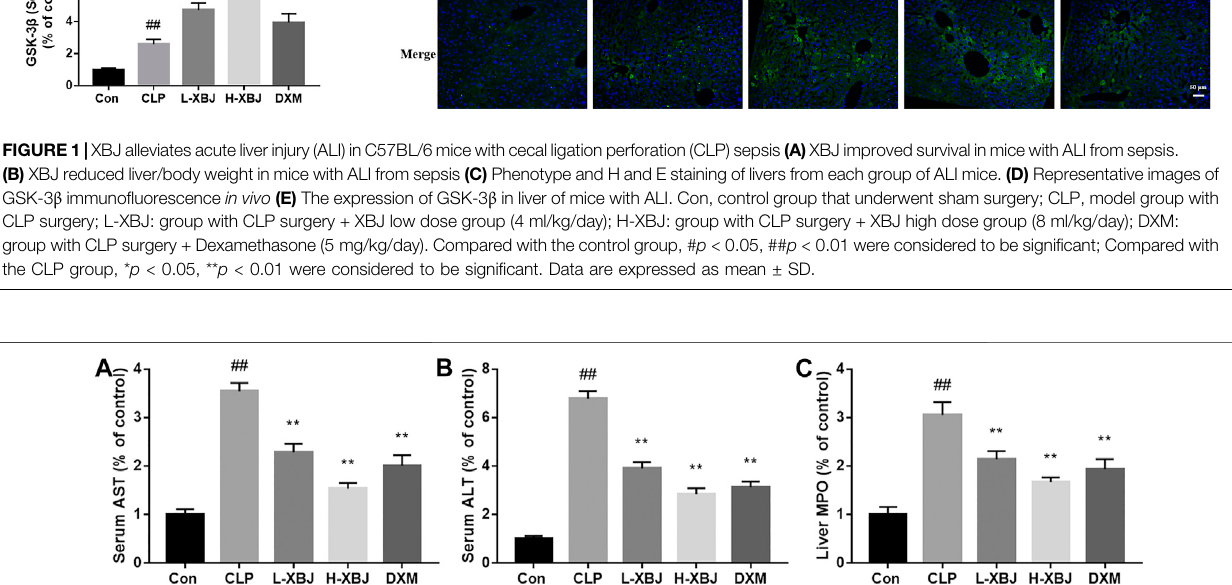
Frontiers in Pharmacology |